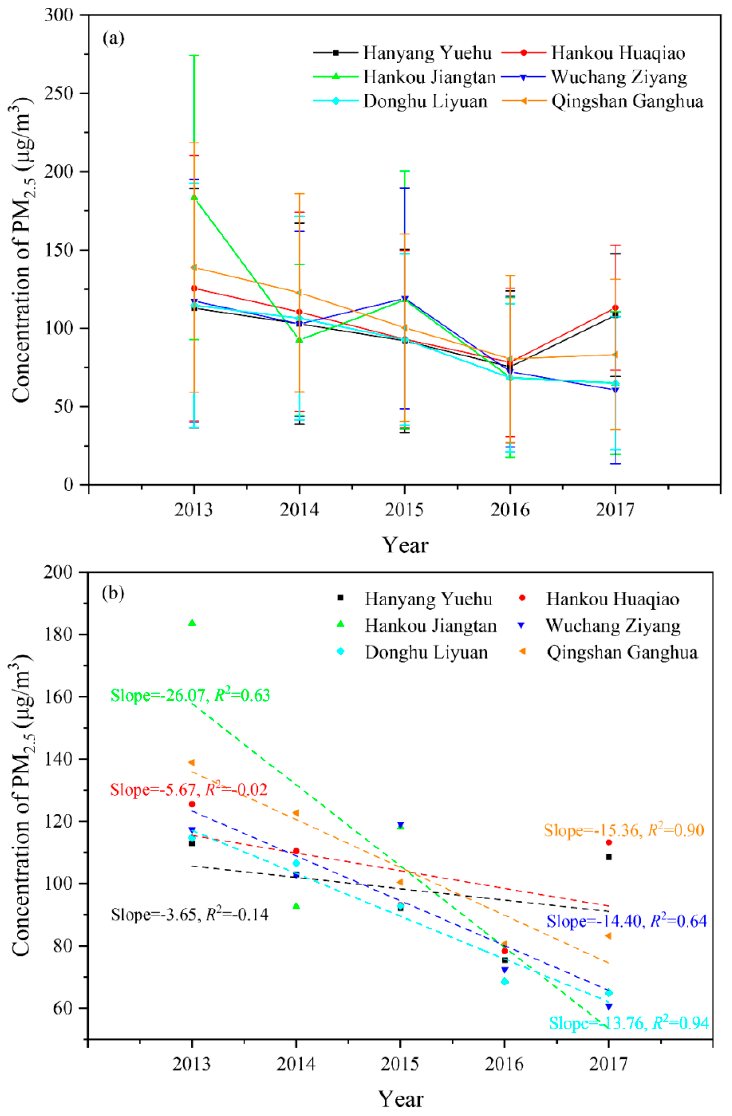
Figure 2. ( a ) Annual mean PM 2.5 concentrations and standard deviations at various monitoring sites in the period of 2013–2017; ( b ) Linear trendlines at various monitoring sites in the period of